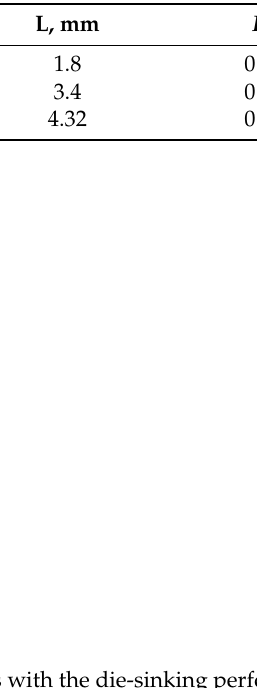
Table 2. Parameters of VA signals for EDM of IN23 ceramics.